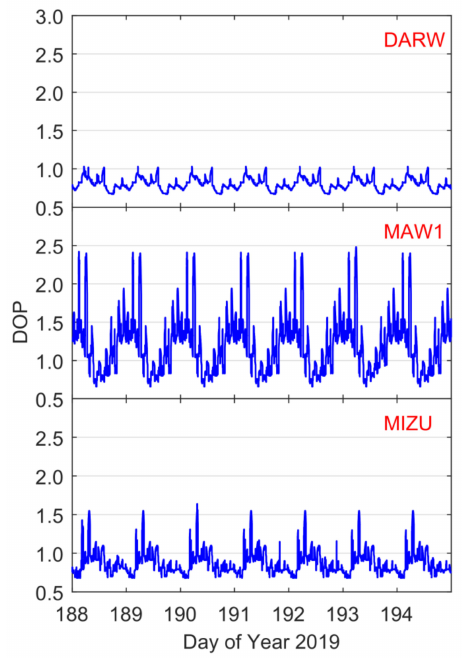
Figure 14. Time series of epoch-wise DOP corresponding to ISB estimates derived from GPS/IRNSS integrated SPP at stations DARW, MAW1, and MIZU on 7–13 July (DOY 188 to 194),